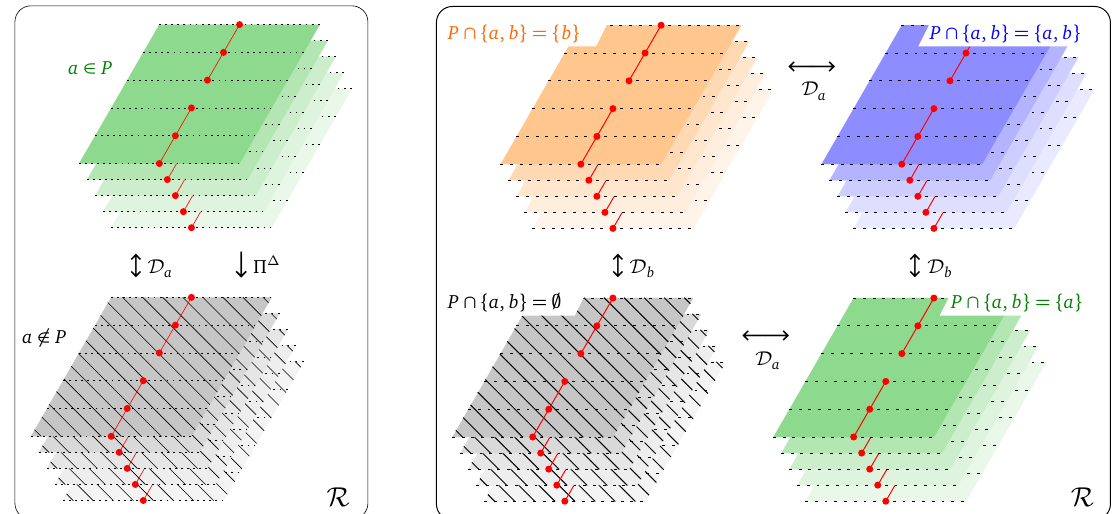
Figure 16: Choice of a fundamental domain of R under the action of g ∆ with ∆ = { a } (left) and ∆ = { a , b } (right). The sheets (cid:67) , partitioned along dashed lines into pairs P = S l, m ∪ S r, m of half-infinite strips S m from (39), are grouped together according to P P P the value of P ∩ ∆ . The fundamental domain corresponding to R ∆ is the hatched portion, made from the sheets (cid:67) with P ∩ ∆ = (cid:59) . How sheets are glued together P along branch cuts (red lines, with dots for the branch points) is not represented for